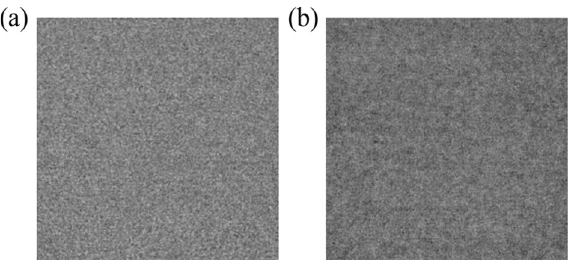
Figure 7. BF1 response image ( a ) System interferogram, ( b ) NO 2 interferogram.